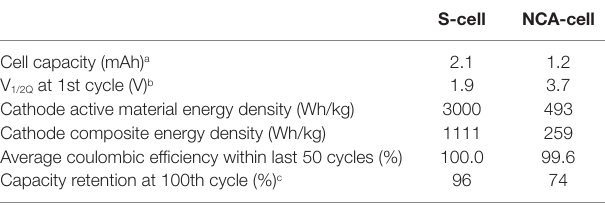
TaBle 2 | summary of the cell characteristics.